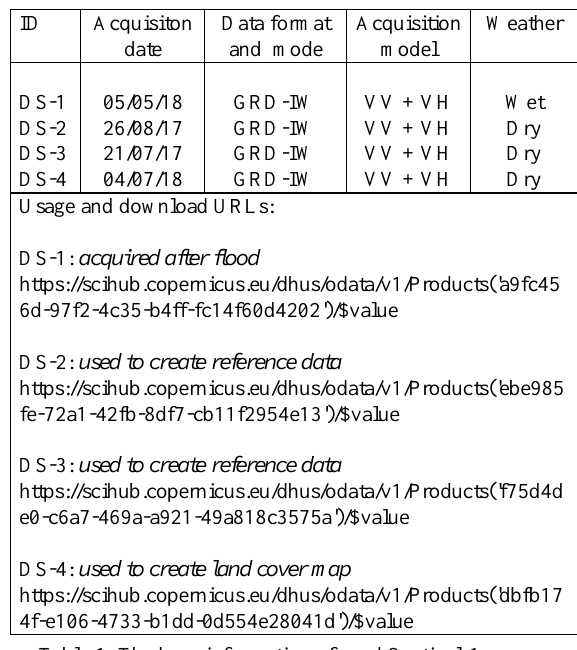
Table 1. The base information of used Sentinel-1